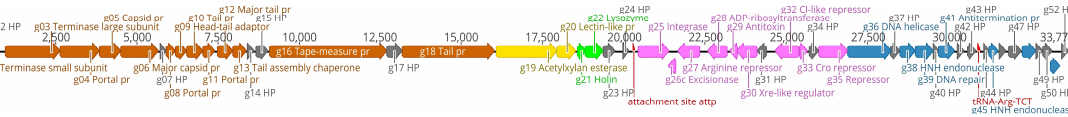
Figure 4. The annotated genome map of fEgAb01. The predicted genes are shown as colored arrows labelled with predicted functions (Genes encoding structural proteins, brown; lysogen functions, purple; nucleic acid enzymes, blue; hypothetical proteins, grey; tRNA gene and the 3’-cohesive end, red; lysis functions, green; carbohydrate interactions, yellow; for details see Table S3). The map was drawn with Geneious 10.2.6 (www.geneious.com). HP, hypothetical protein; pr,